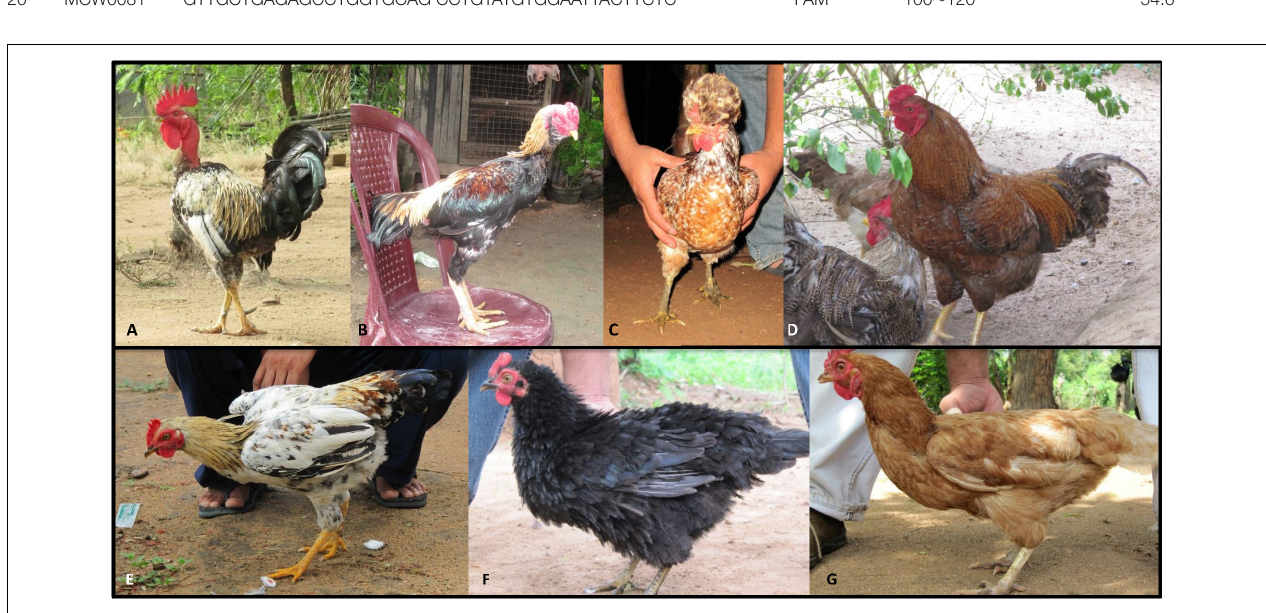
FIGURE 2 | Chicken phenotypes in Sri Lanka. (A) Naked neck; (B) long legged; (C) crested or crown; (D) Giriraj; (E) non-descript chicken; (F) frizzle feathered; (G) commercial layer.